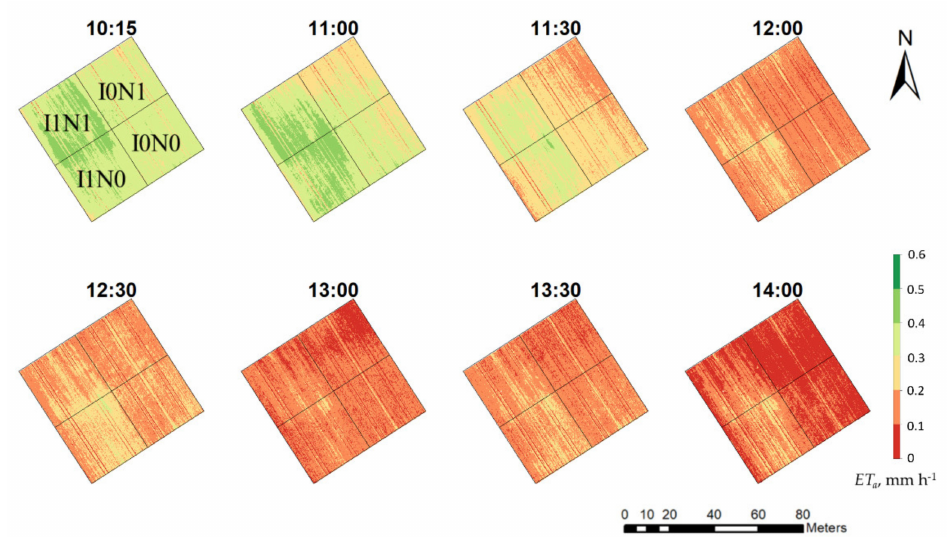
Figure 9. Spatiotemporal dynamics of actual evapotranspiration ( ETa ) for winter wheat fields on half-hour steps on 6 June 2018 in Denmark. I0, I1 and I2 are minimum, optimum and full irrigation, respectively. N0 and N1 are without and with additional fertilization.